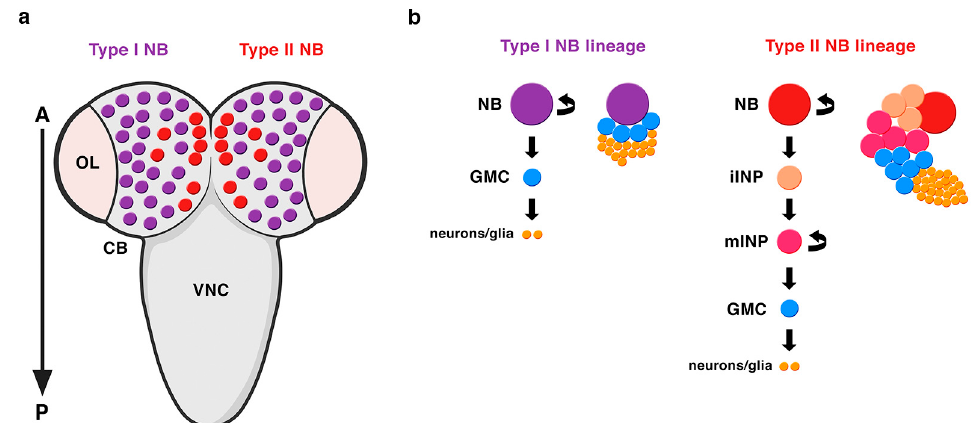
Figure 3. Types of NBs in the Drosophila CNS. ( a ) A dorsal view of the larval central brain (CB) containing type I (purple) and type II (red) NBs. There are only eight type II NB lineages per brain hemisphere located at very specific positions at the dorso-medial part of the CB. OL: optic lobe; VNC: ventral nerve cord; A: anterior; P: posterior. ( b ) Type II NB lineages are bigger than type I NB lineages. In type II NB lineages, the NB divides asymmetrically to generate another NB and, instead of a GMC (like in type I NB lineages), an intermediate progenitor (INP), which after a process of maturation, divides asymmetrically to give rise to another INP and a GMC. iINP: immature INP; mINP: mature INP (modified from Carmena, Fly, 2018).